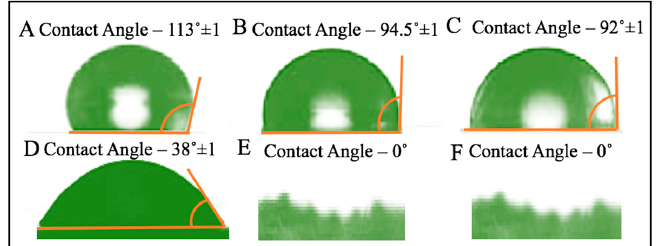
Figure 4. Contact Angle of coated and uncoated fabric. ( A ) Coated after 0 s; ( B ) Coated after 20 s; ( C ) Coated after 2 min; ( D ) Uncoated after 0 s and ( E ) Uncoated after 20 s, and ( F ) Uncoated after 2 min.